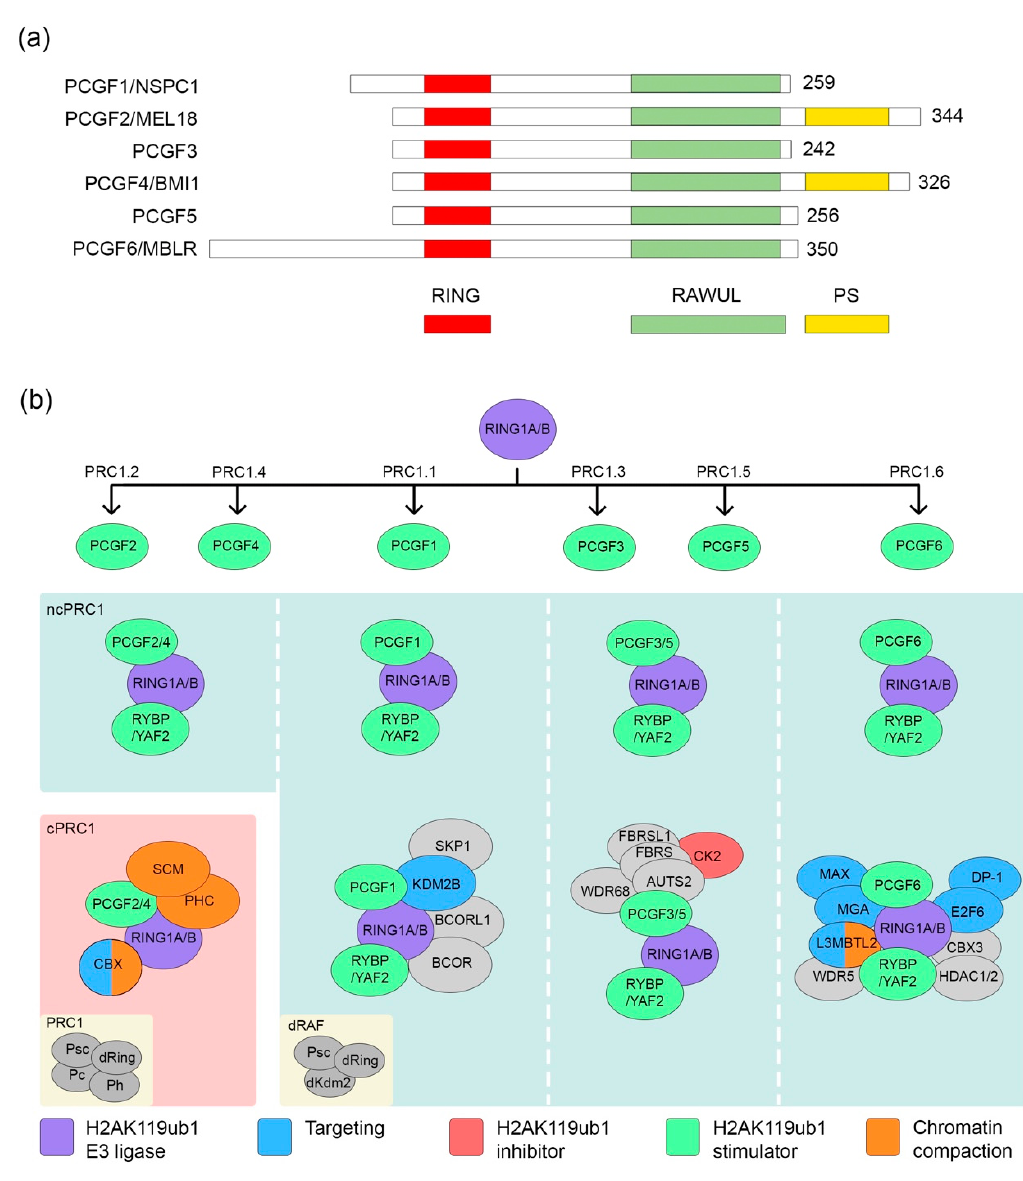
Figure 1. The domain architecture of Polycomb group RING finger (PCGF) proteins and the composition of Polycomb Repressive Complex 1 (PRC1) complexes. ( a ) PCGF proteins share highly conserved protein domains (RING and RING finger and WD40-associated ubiquitin-like (RAWUL)) and unique protein domains (PS) are only present in PCGF2 / 4; ( b ) The classification of PRC1 complexes. Based on PCGF proteins, PRC1 can be divided into six categories, PRC1.1–6. In the presence of RING1 and YY1 Binding Protein (RYBP) / YY1 Associated Factor 2 (YAF2) or CBX / PHC / SCM proteins, PRC1 can be classified as canonical PRC1 complexes (cPRC1) and non-canonical PRC1 complexes (ncPRC1). Inserts on the left bottom show the corresponding Drosophila complexes.